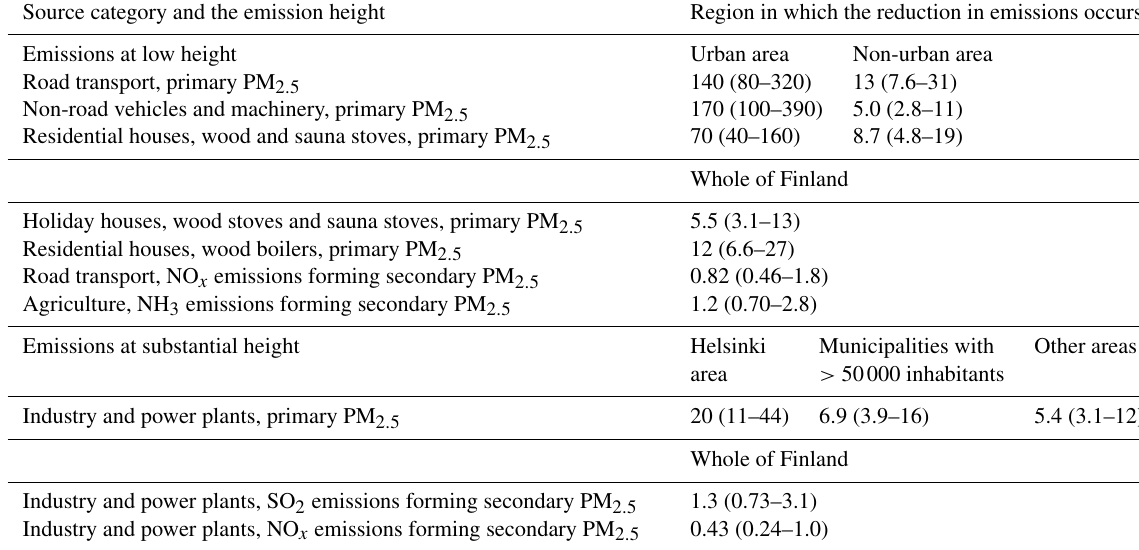
Table 4. Economic benefits obtained from the assumed reductions in emissions in 1000 EUR per tonne of emissions. The results are presented for the various source categories in various domains. The first presented value has been computed based on the average value of life year, and the two values in parenthesis are based on the median value of life year and the average value of statistical life,